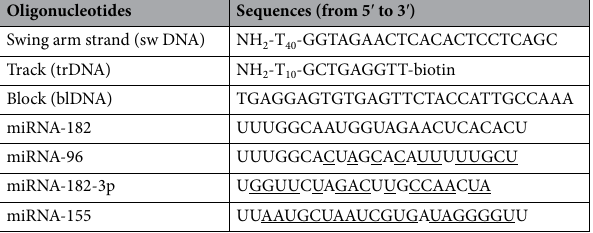
Table 1. Sequences of DNAs and